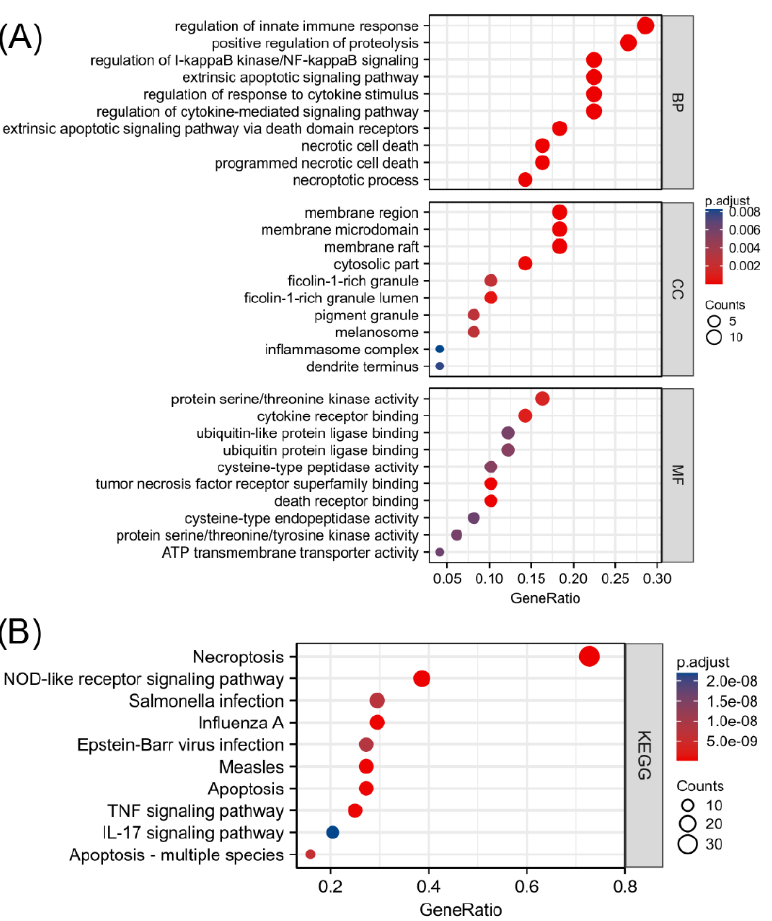
Figure 3. Functional enrichment analysis of differentially expressed NRGs. ( A ) Top 10 enriched biological processes, molecular functions, and cellular components identified by the GO analysis. ( B ) Top 10 significant signaling pathways identified by the KEGG analysis.